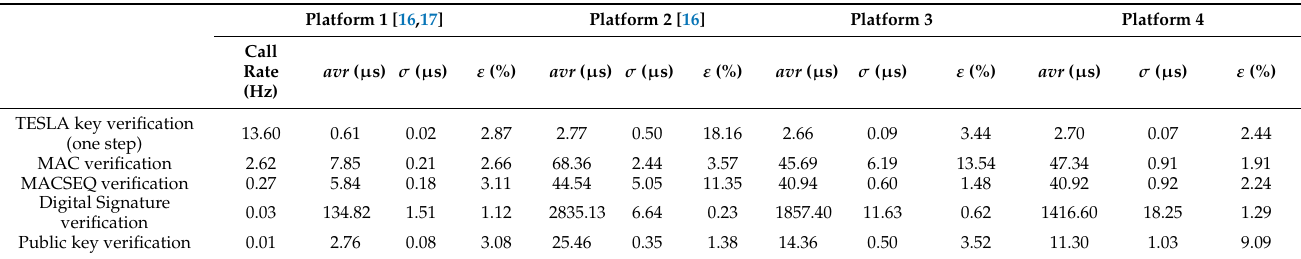
Table 4. Software profiling analysis results obtained with the set of parameters S1 in Table 3. © [2020] IEEE. Extended, with permission, from [16].